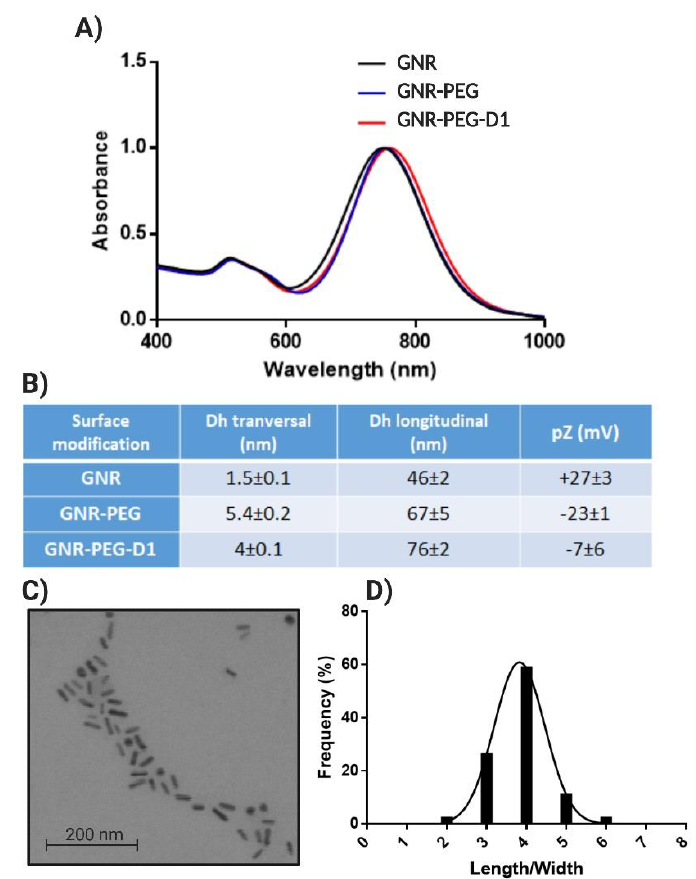
Figure 4. GNRs characterization: UV–vis-NIR spectra of GNRs ( A ), size distribution obtained by Dynamic Light Scattering (DLS) and zeta potential (pZ) for GNRs ( B ), STEM of GNRs ( C ), and aspect ratio length/width obtained from 500 particles ( D ).